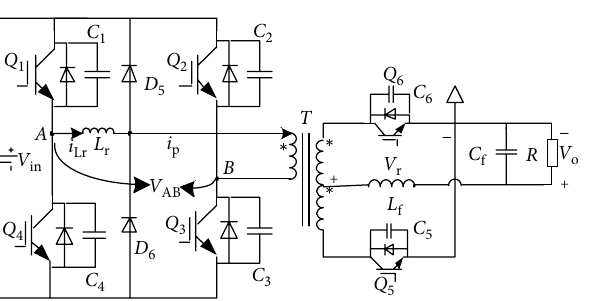
Figure 1: Main circuit of PSFB DC/DC converter.